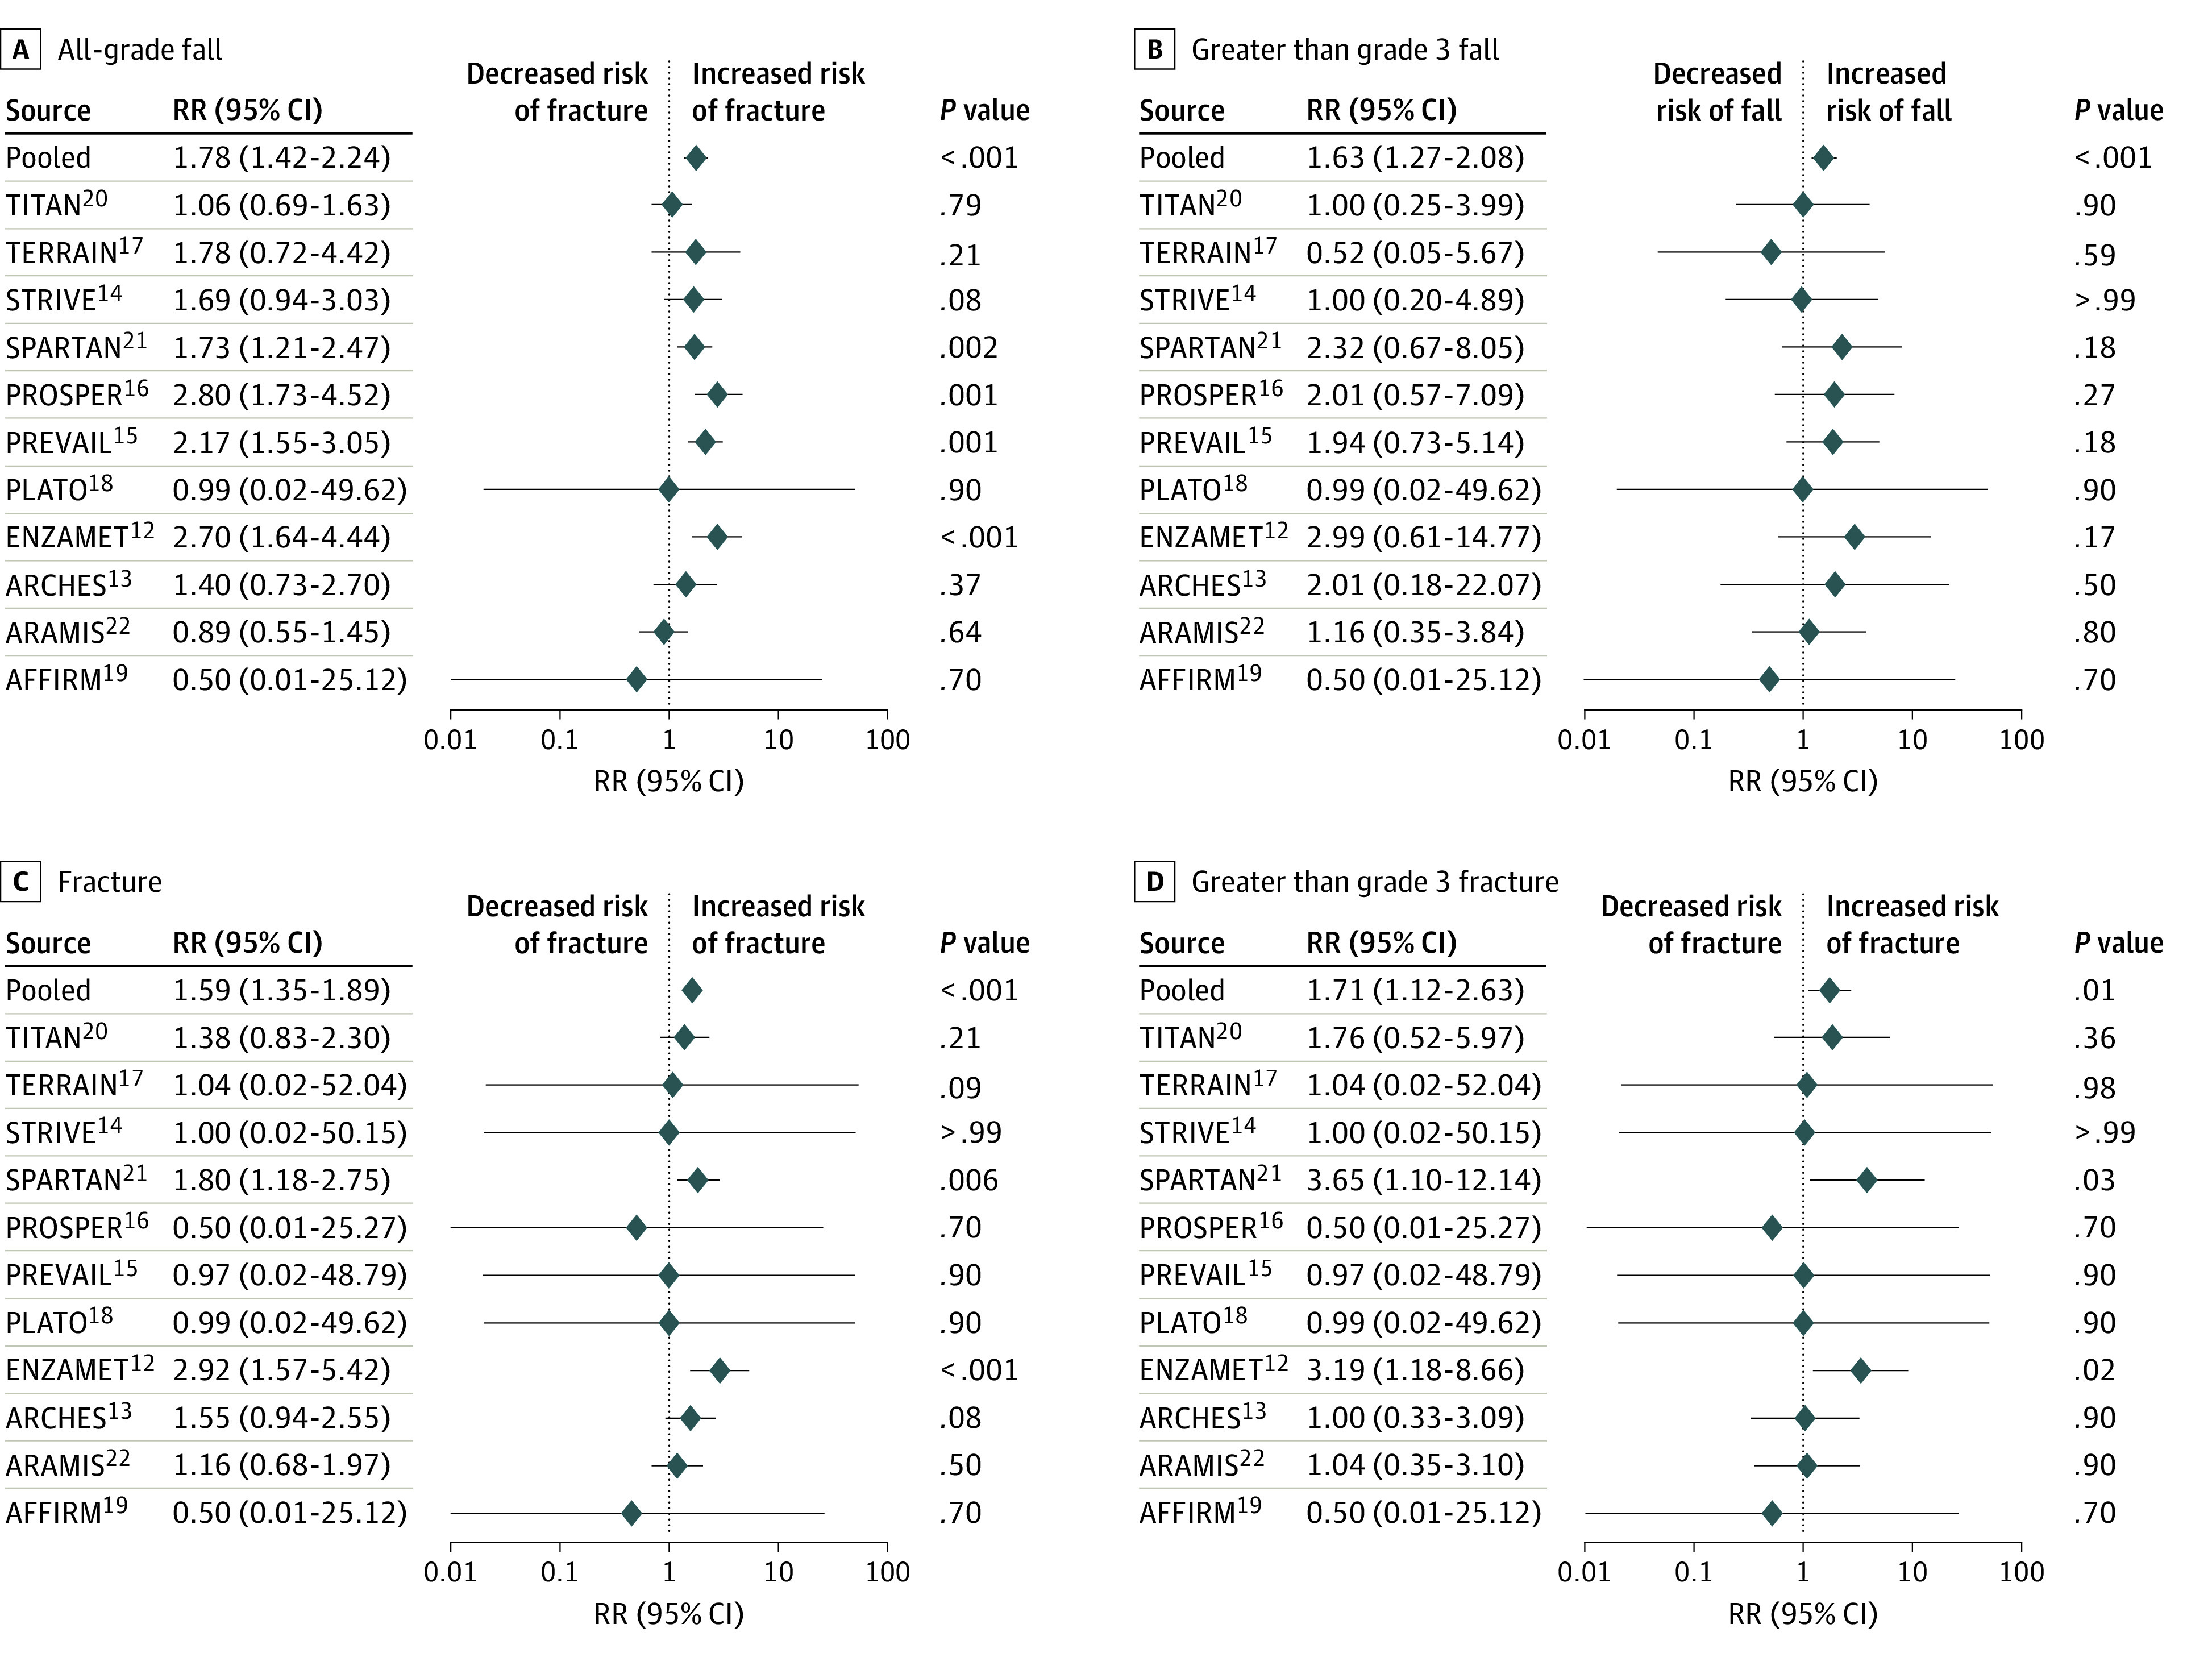
Risk of Fracture or Fall Among Included StudiesGraphs show relative risks (RRs) and 95% CIs for all-grade falls (A), greater than grade 3 falls (B), all-grade fractures (C), and greater than grade 3 fractures (D).